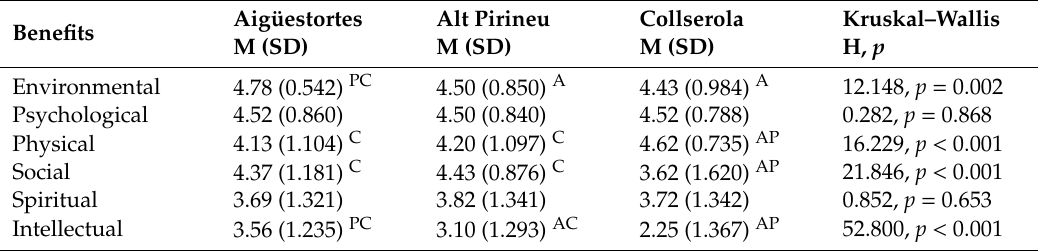
Table 6. Visitors’ perceived health and well-being benefits. Descriptive statistics and comparisons between parks.